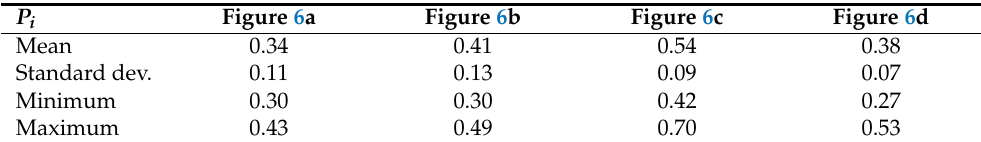
Table 1. Participants’ degree of agreement P i calculated for a sample of images i misclassified under their ten presented versions. Note the images are the ones illustrated on Figure